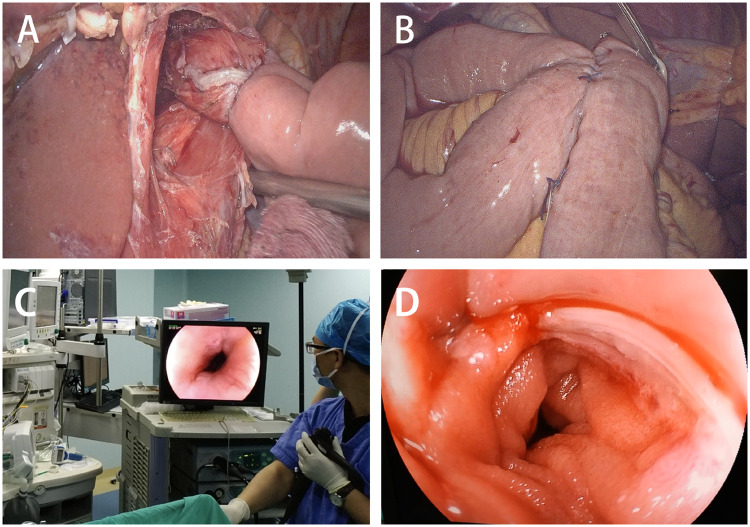
Evaluating the anastomosis routinely. (A) and (B) Evaluation of anastomotic stoma in the laparoscopic view. (C) and (D) Evaluation of anastomotic stoma with on-table endoscopy.